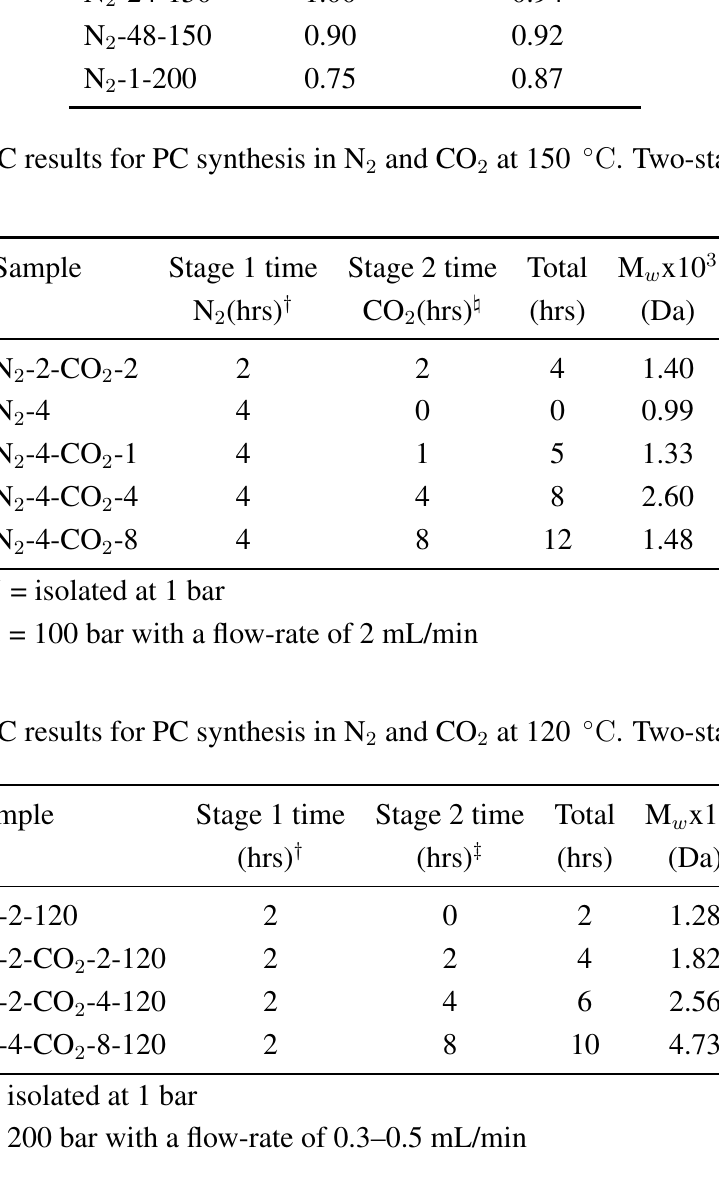
Table 4. GPC results for PC synthesis in N